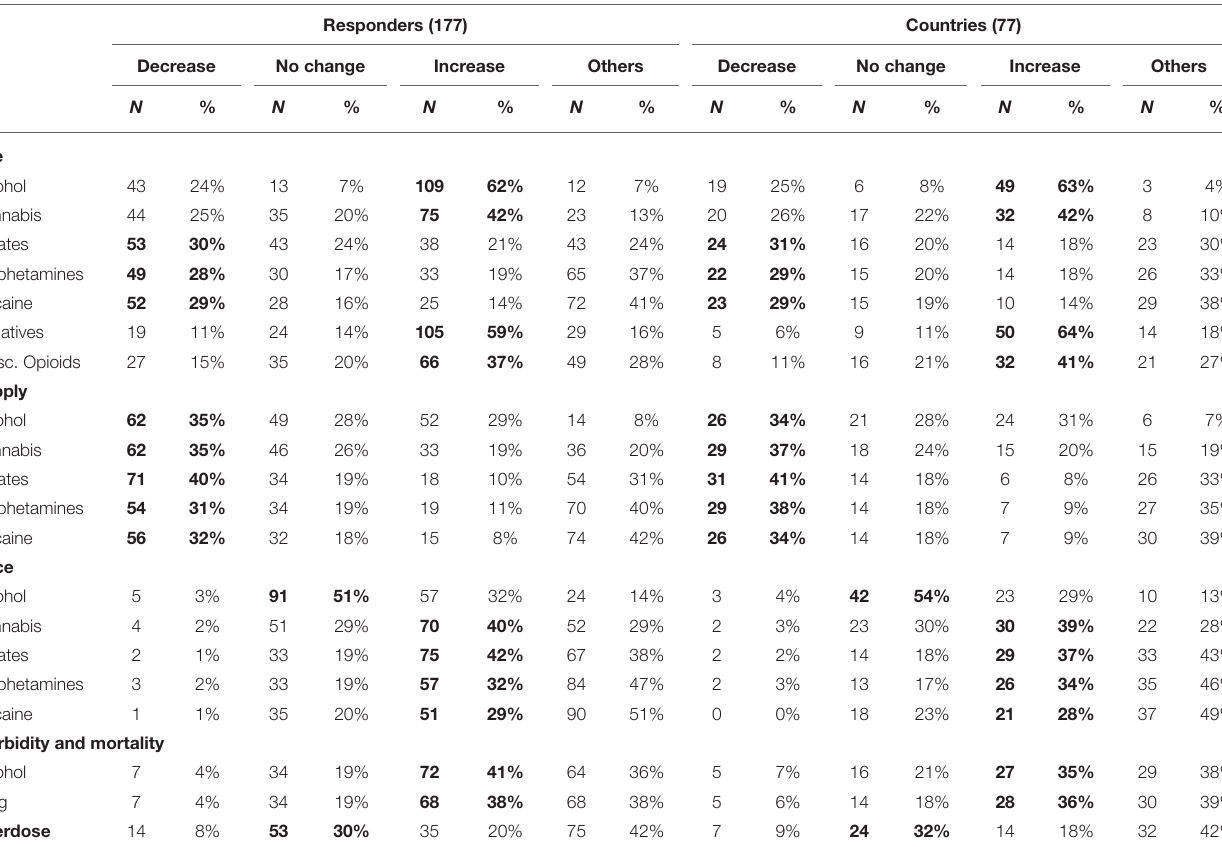
TABLE 2 | Summary of the survey responses in different sections related to situational assessment including respondents’ information about changes in alcohol and drug use pattern, supply, price, morbidity and mortality, and